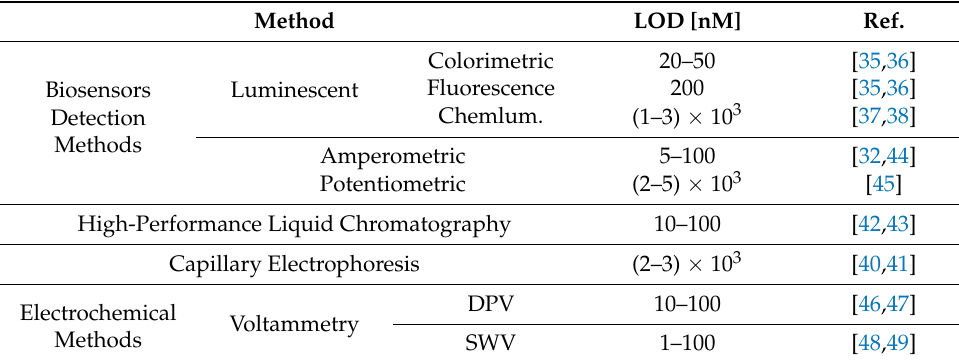
Table 1. Comparison of different UA detection